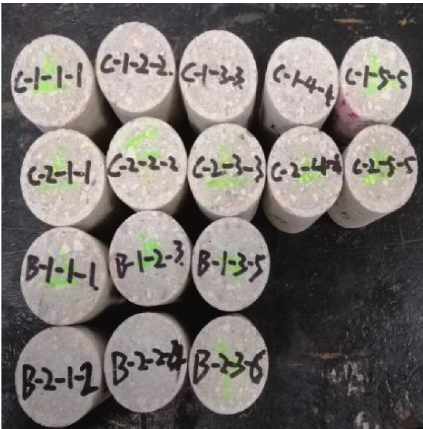
Figure 11: Specimens required for triaxial testing. Table 3: Peak shear stress statistics of each group.